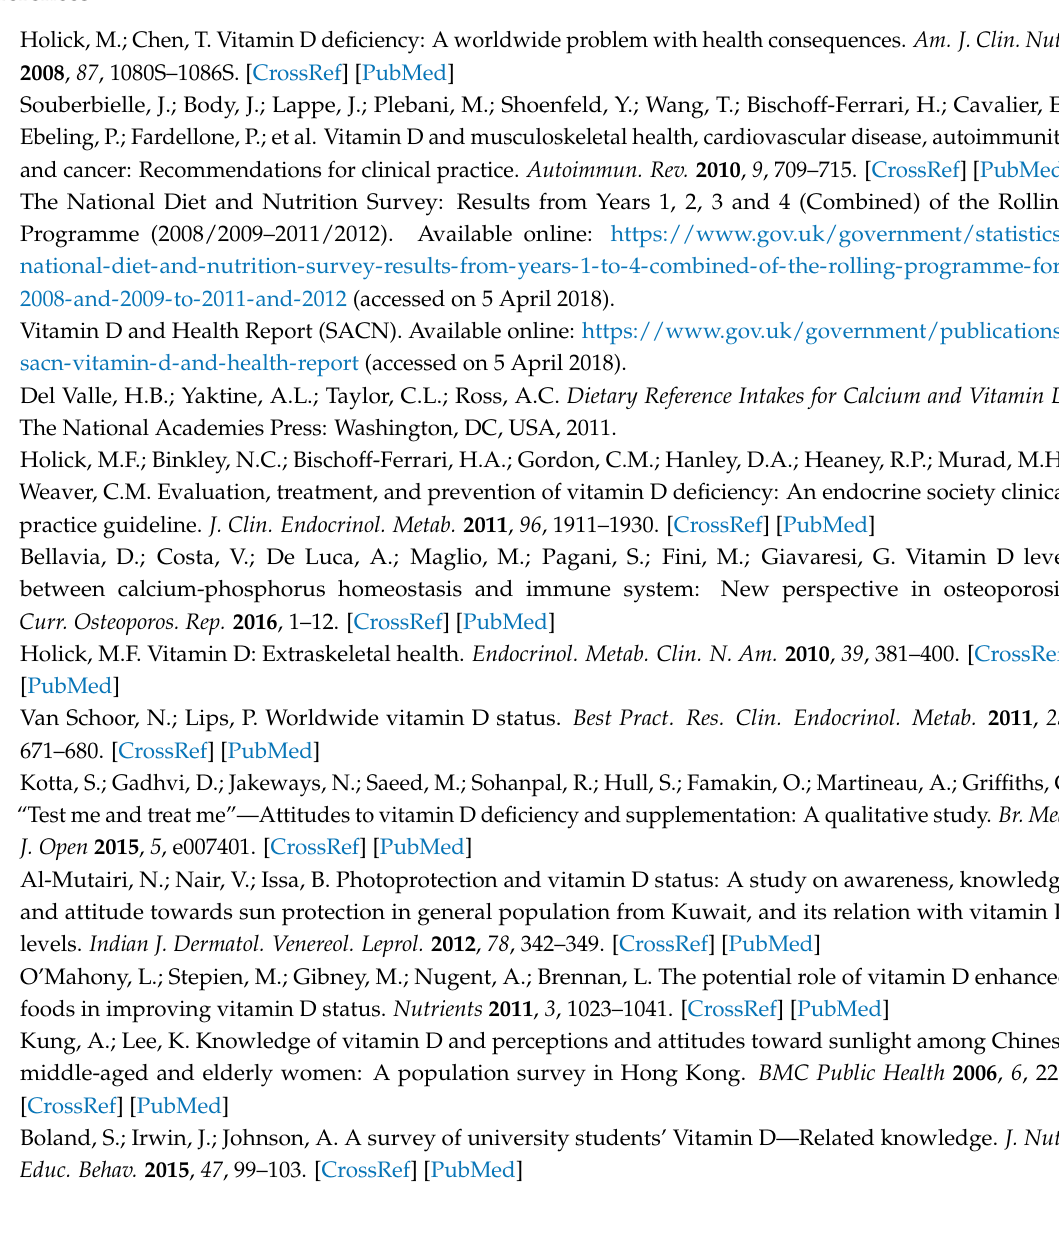
s1, Figure S1: title, Table S1: title, Video S1: